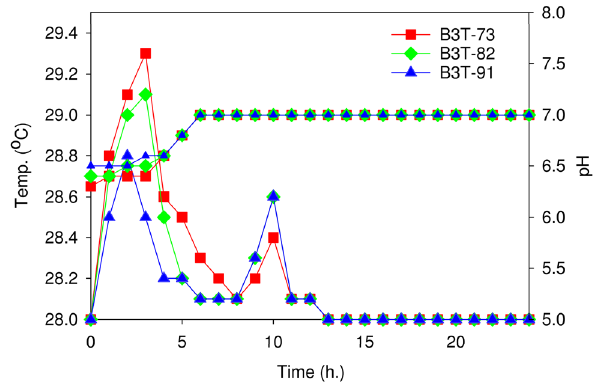
Fig. 4 Typical of temperature and pH profile of bio-coal briquettes as a function of fermentation